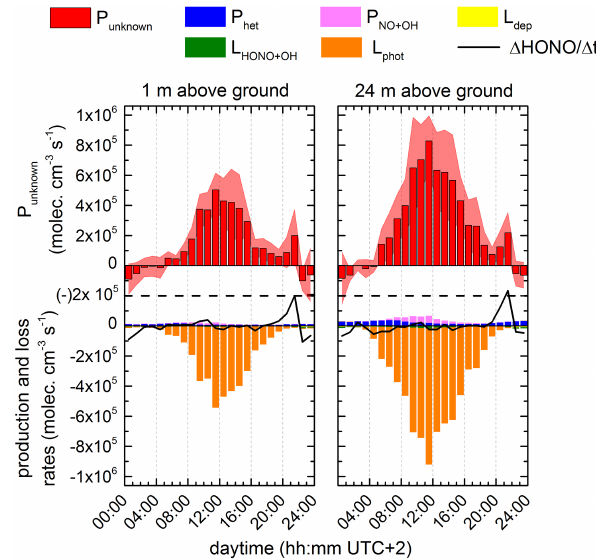
Figure 5. The diel variation of P unknown (red bars, upper panel) with standard deviation (red shade), the single production and loss terms (coloured bars, lower panel) and the change in HONO concentration ( (cid:49) HONO/ (cid:49) t) (black line, lower panel) for the two heights are